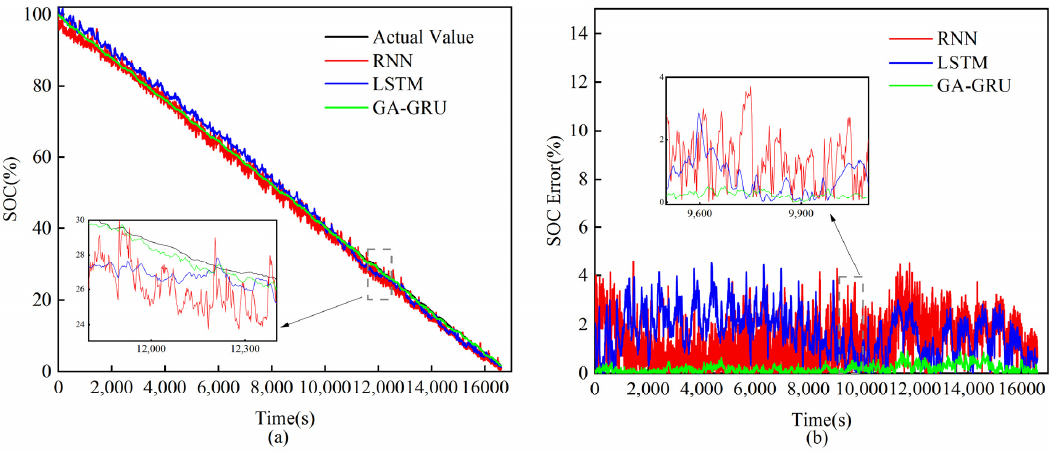
results under DST at 30 °C; ( b ) comparison of SOC estimation errors under DST at 30 °C.